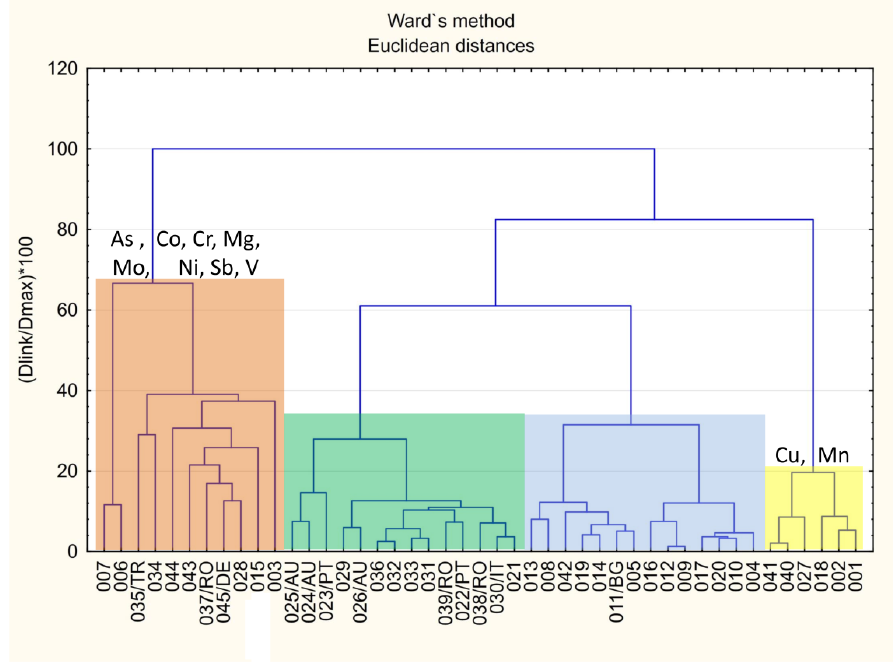
Figure 4. Classification of honey samples according to cluster analysis. First one (marked with yellow) contains honey with the highest content of copper and manganese with mean value of 367 μg/kg (0.367 mg/kg) and 1172 μg/kg (1.172 mg/kg), respectively. On the opposite side of dendrogram, CA creates cluster containing 11 samples of honey with elevated content of arsenic, cobalt, chromium, magnesium, mo- lybdenum, nickel, antimony and vanadium. Honey from some countries other than Po- land were grouped in a cluster marked in green (12 out 18 samples). Both clusters located in the middle of the tree graph (indicated by green and blue colors) were characterized by moderate values of analyzed PTEs. The hypotheses that origin and type of honey is influencing PTEs composition have also been tested for Polish samples (post hoc tests: Tuckey honest significance for unequal N, p < 0.05 and Newman Keuls, p < 0.05), but no significant differences were found in the case of origin. In contrast to this fact, types of honey are related to different content of zinc (elevated in buckwheat honey and smallest in rapeseed honey), elevated amount of nickel and cobalt in honeydew honey. 2.3. Bioelements Content in Honey Due to the consumption of honey by people around the world, the content of mineral salts, and thus the presence of bioelements in honey, was also important in this study. Based on the information available about the composition of the honey, this natural prod- uct contains, in most cases, potassium (up to 500 mg/kg), phosphorus, magnesium and calcium. However, iron, silicon, sulfur, copper, fluoride, zinc and manganese occur in slightly smaller quantities. Moreover, honey contains other important bioelements, such as cobalt, molybdenum, chromium and iodine. The varieties of honey differ, as do the number and content of bioelements, where the average is usually 0.3%, in nectar-type honey it is in the range from 0.01 to 0.035% and in honeydew honey it is approximately 1% [3,5,9]. The content of these metals, which are considered as bioelements, such as mag- nesium, iron, copper, zinc, manganese, cobalt, molybdenum and chromium, have been highlighted. The results of the comparative analysis are presented in Figure 5.